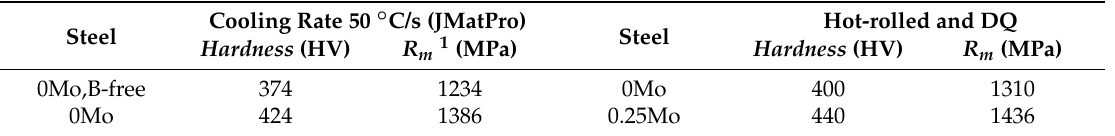
Table 7. Calculated hardness values using JMatPro ® software with and without B alloying compared to measured hardness values from hot-rolled and direct-quenched (DQ)